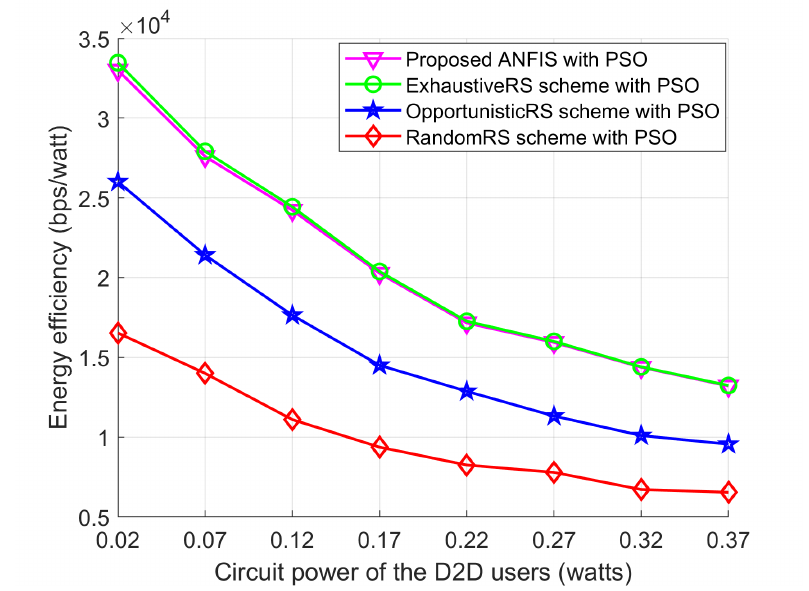
Figure 12. EE performance with P Cir